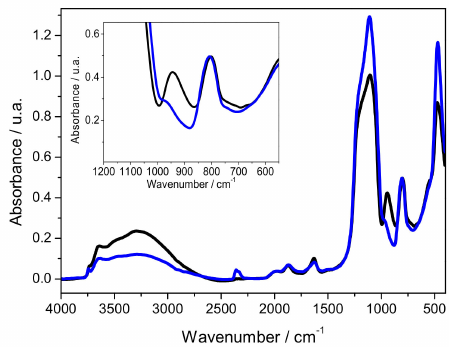
Figure 1. FTIR spectra of nanosilica clusters. Black: SiO 2 (c). Blue: SiO 2 (c)F. Inset: Magnification of FTIR spectra in the temperature range of 1200–550 cm − 1